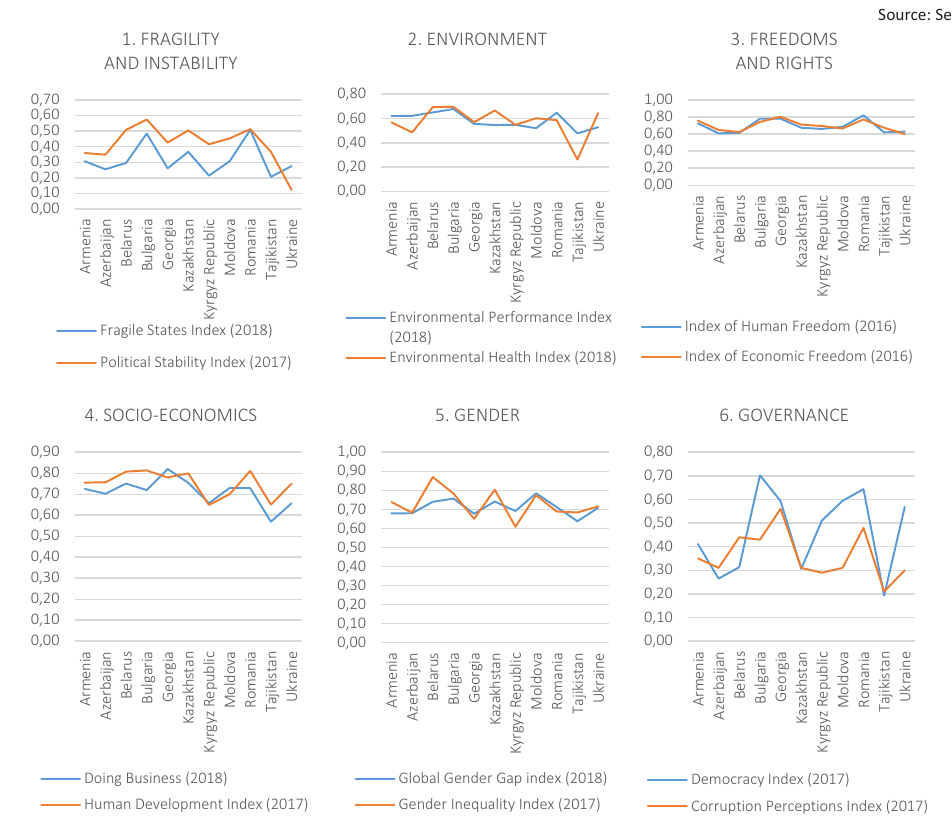
Figure 2. Institutional development matrix